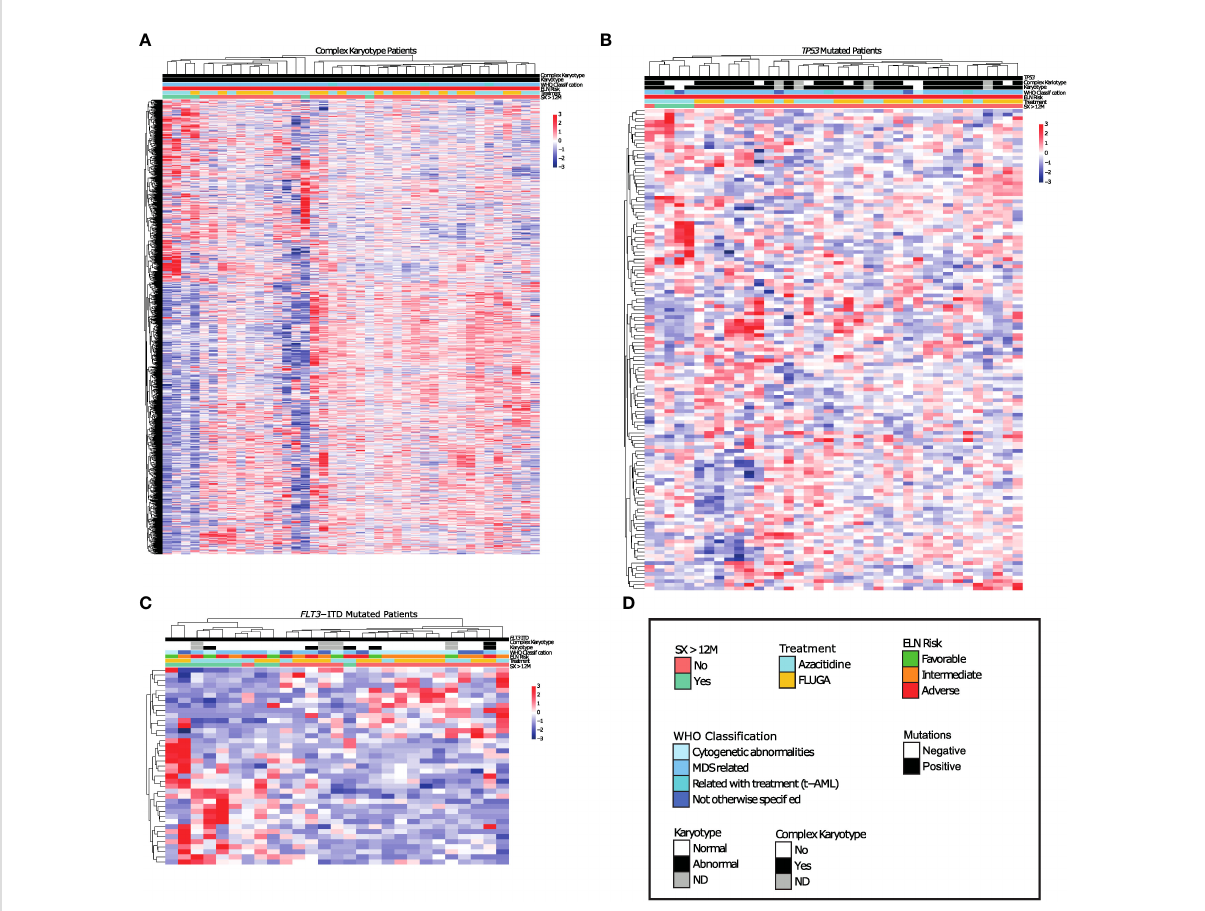
FIGURE 2 Long survival AML patients with complex Karyotype or TP53 mutations show differential transcriptomic pro fi le respect to non-long survival AML patients with these same genetic alterations. (A-C) Differential expression analysis between long survival AML patients and non-long survival AML patients with (A) Complex Karyotype, (B) TP53 mutations. (C) FLT3-ITD mutations. (D)